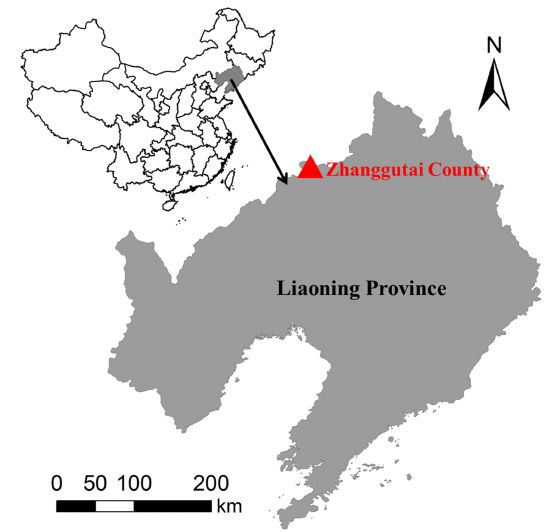
Figure 1. Location of the experimental